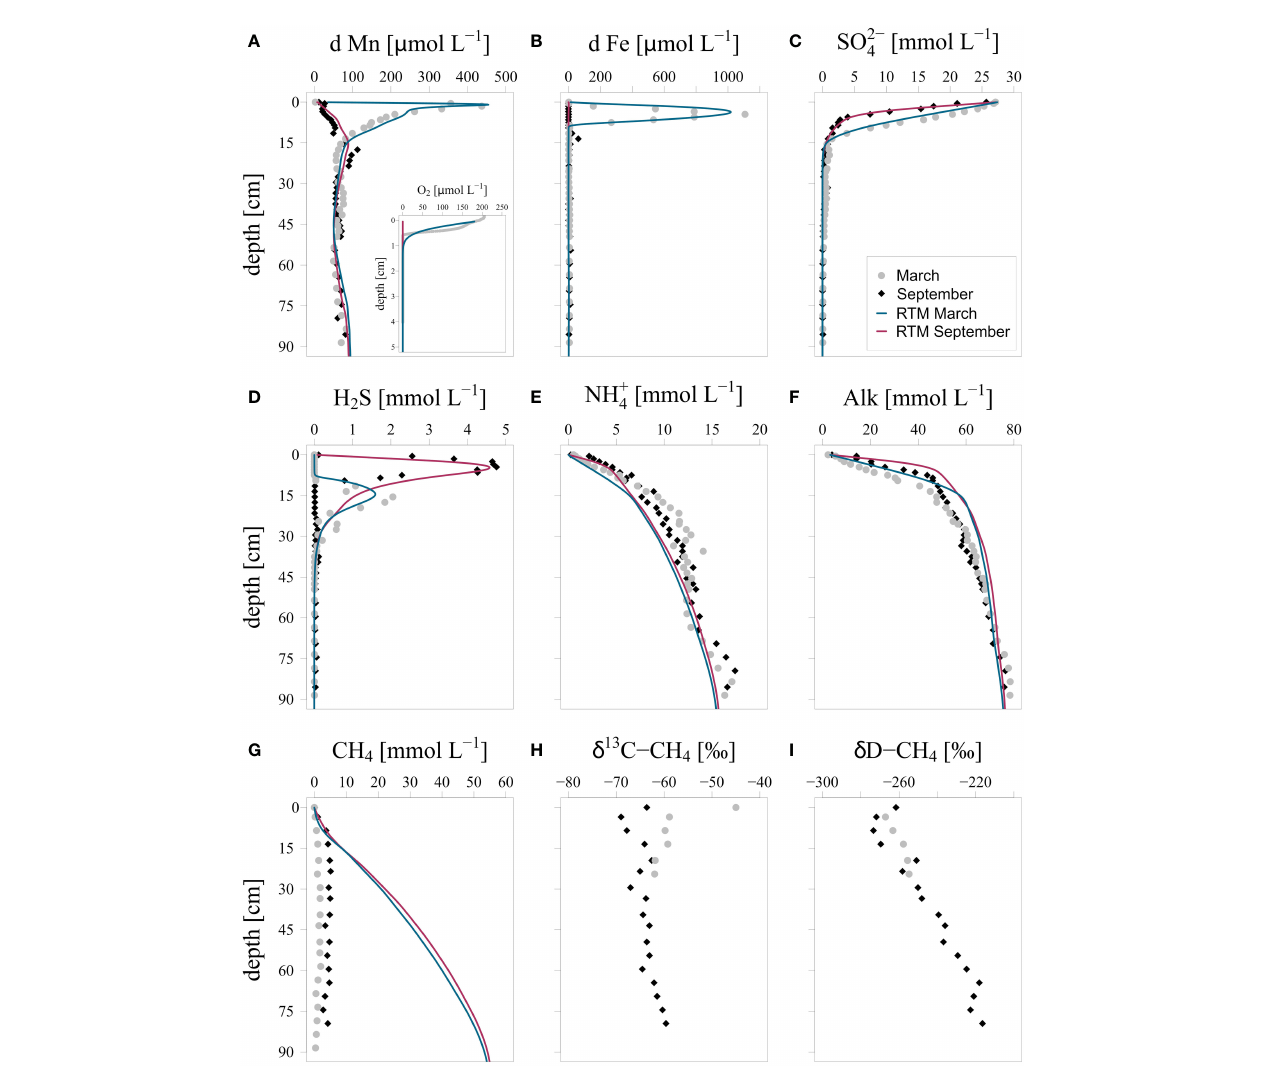
FIGURE 2 Porewater depth pro fi les of measured and modeled (A) : O 2 and d Mn, (B) : d Fe, (C) : SO 2 (cid:1) 4 , (D) : H 2 S, (E) : NH + 4 , (F) : alkalinity, (G) : CH 4 , (H) : d 13 C-CH 4 and (I) : d D-CH 4 . d 13 C-CH 4 values are given in ‰ vs. VPDB (Vienna Pee Dee Belemnite) and d D-CH 4 values are given in ‰ vs. V-SMOW (Vienna Standard Mean Ocean Water). d Mn and d Fe refer to dissolved Fe and Mn (< 0.45 µm fi lter). Blue and red lines indicate results of the reactive transport model (RTM) for March and September 2020. Note that the data point for a depth of 0 cm refers to bottom